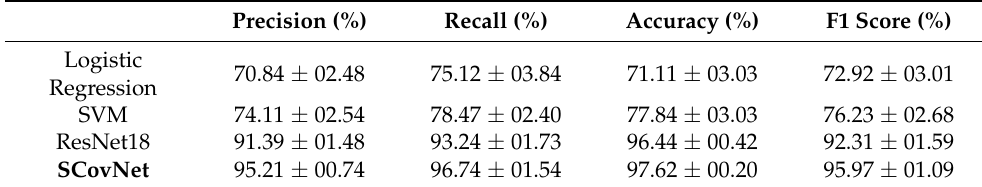
Table 2. Overall performance assessment ( µ ± σ ) for CXR images. Precision (%) Recall